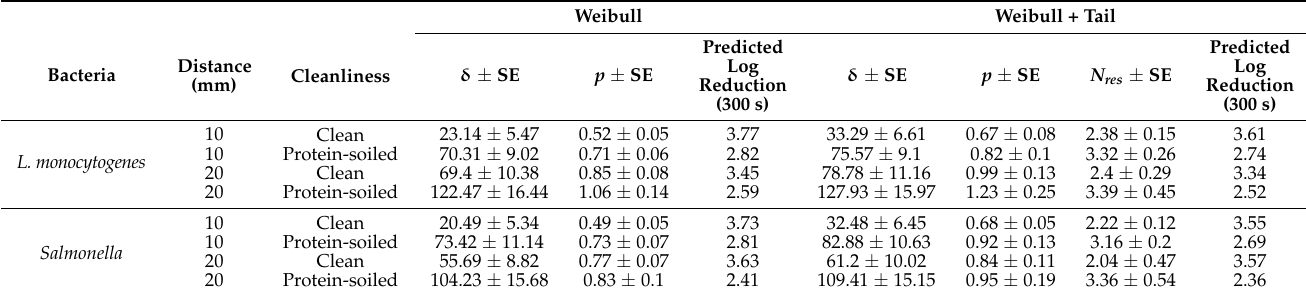
Table 3. Comparison between Weibull and Weibull + tail model parameters and predicted log reduction achieved during the study period (300 s). Weibull Weibull + Tail Bacteria Distance